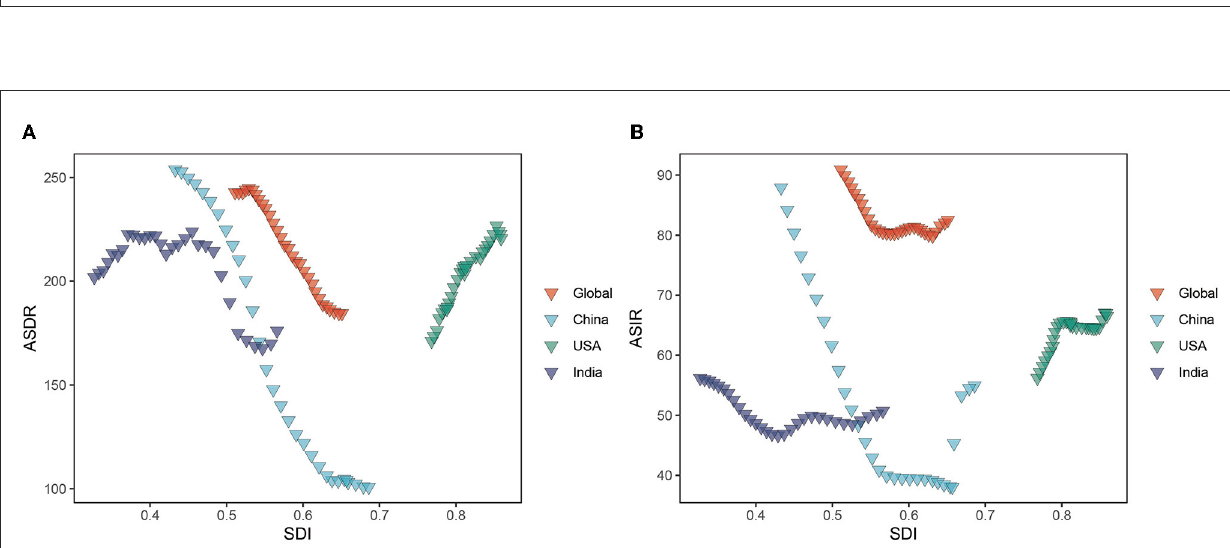
FIGURE8 ASDR and ASIR of HCV burden in different regions by SDI from 1990 to 2019. (A) ASDR; (B) ASIR. ASIR, age-standardized incidence rate; ASDR, age-standardized DALY rate; SDI, Socio-demographic